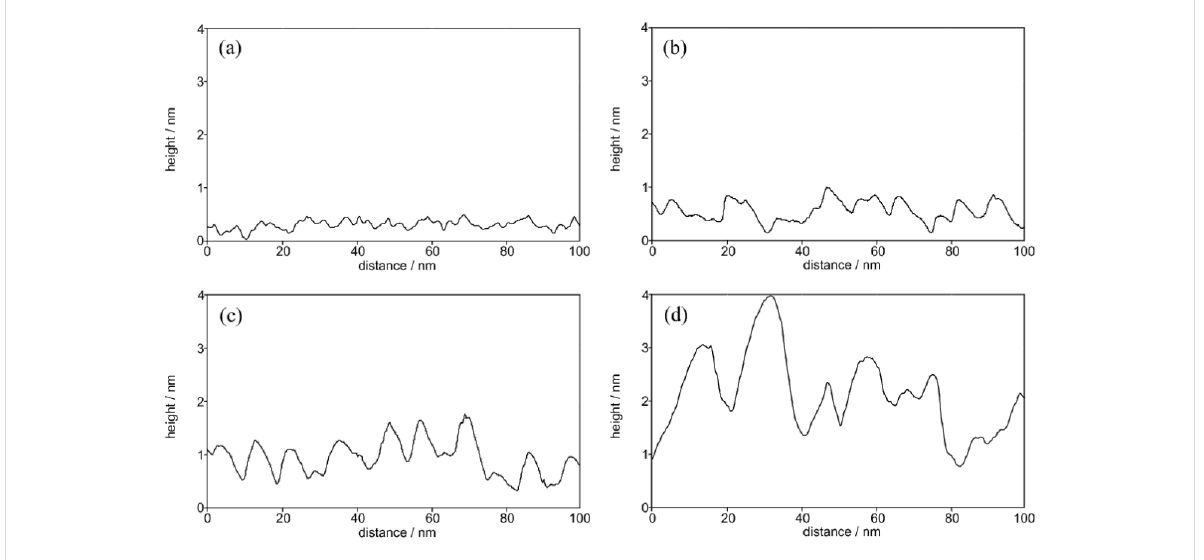
Figure 7: Height profiles of the CO-cooled Ir(210) surface in 0.1 M H 2 SO 4 after cycling between − 0.28 and 0.7 V at 1 V·s − 1 for (a) 1, (b) 20, (c) 60 and (d) 240 min.